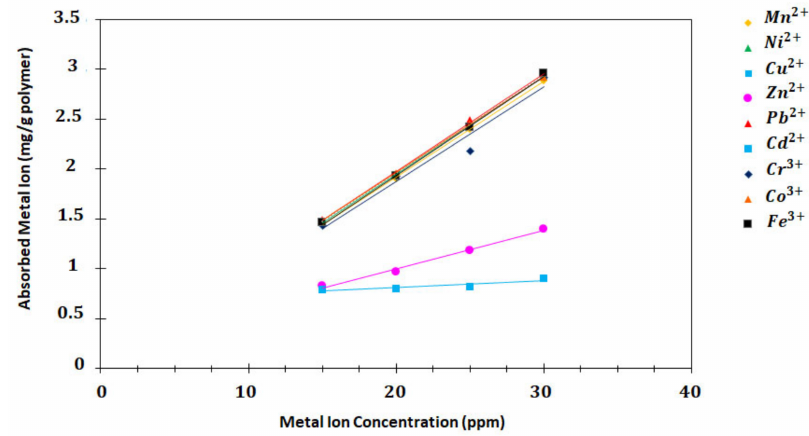
Figure 9. The sorption capacity graph of the SAP against di ff erent concentrations of the metal ions (mg / g polymer).